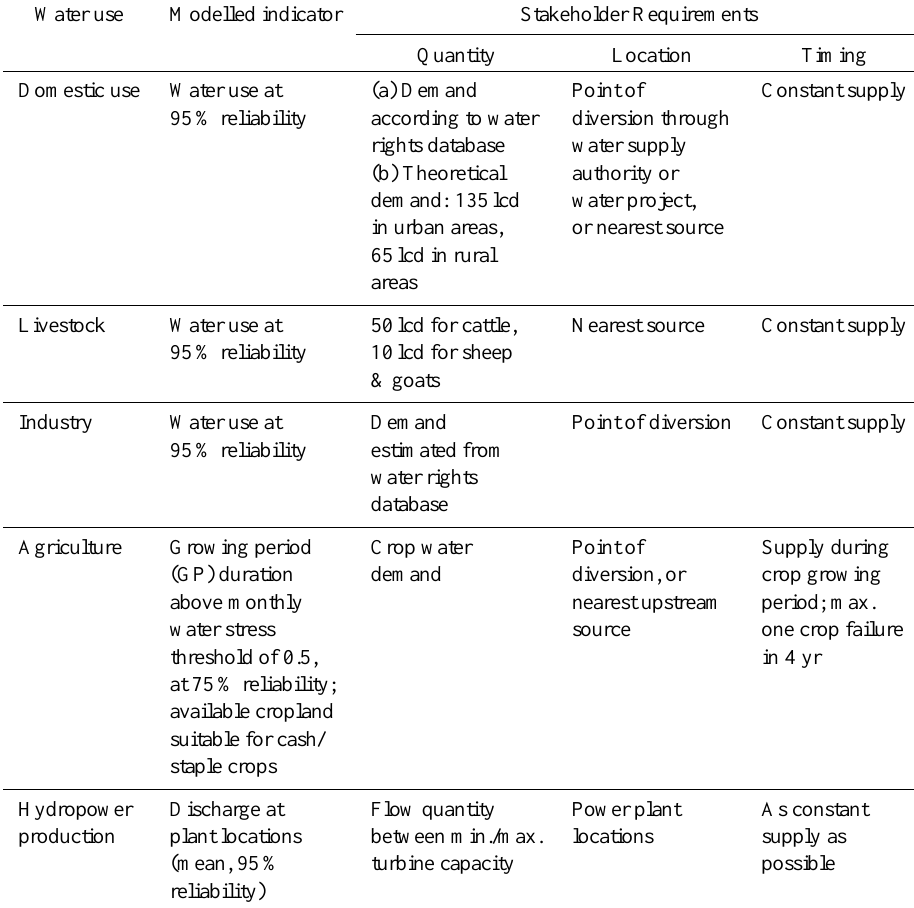
Table 3. Indicators and stakeholder requirements for water provision for different